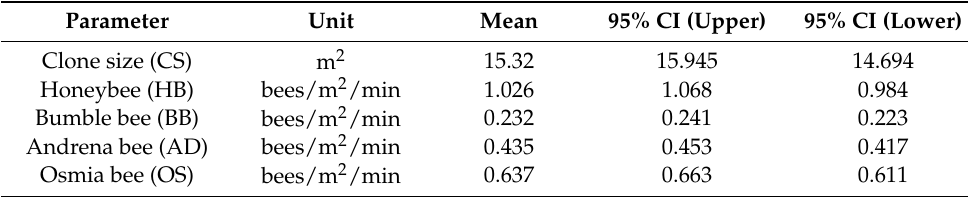
Table 3. The optimal parameter set of the best metamodel found by the multi-objective optimization algorithm [54] when XGBoost was calibrated to the observed fruit-set of the six bog blueberry field sites (CBS, GHS, JMS, MH, TH, and YC) in the years 2015 and 2016. Parameter Unit Mean 95% CI (Upper) 95% CI (Lower) Clone size (CS) m 2 15.32 15.945 14.694 Honeybee (HB) bees/m 2 /min 1.026 1.068 0.984 Bumble bee (BB) bees/m 2 /min 0.232 0.241 0.223 Andrena bee (AD) bees/m 2 /min 0.435